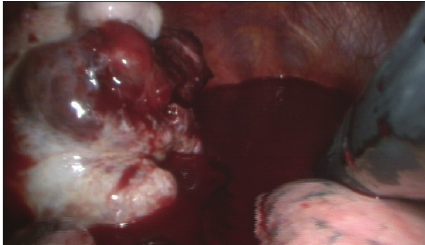
Figure 2: Intraoperative detection of a bleeding pleural tumour surrounded by a massive